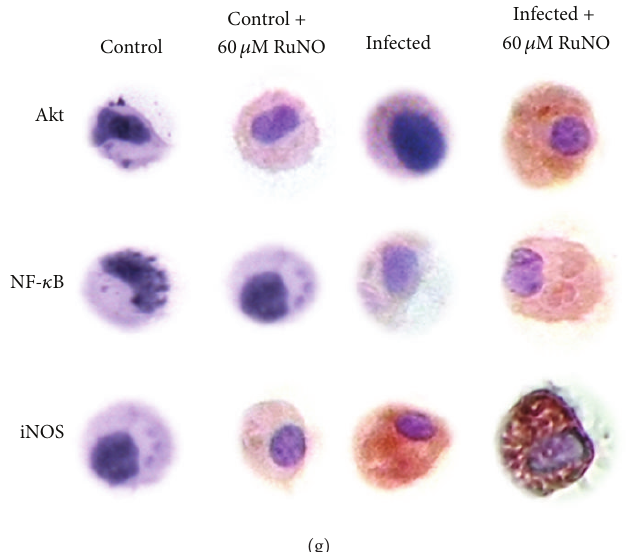
Figure 4: ICC scoring, nuclear staining, and relative quantification of iNOS mRNA of macrophages infected with L. amazonensis and treated with RuNO complex (60 𝜇 M) for 24 h. (a) Akt, (b) phosphorylated Akt (P-Akt), (c) NF- 𝜅 B, (d) phosphorylated p65 (P-p65), (e) iNOS, (f) iNOS mRNA, and (g) immunocytochemical staining. [Values represent the mean ± SEM of three independent experiments ( 𝑃 < 0.05 ). [ ∗ significantly different from control infected, # significantly different from treated control, and + significantly different from